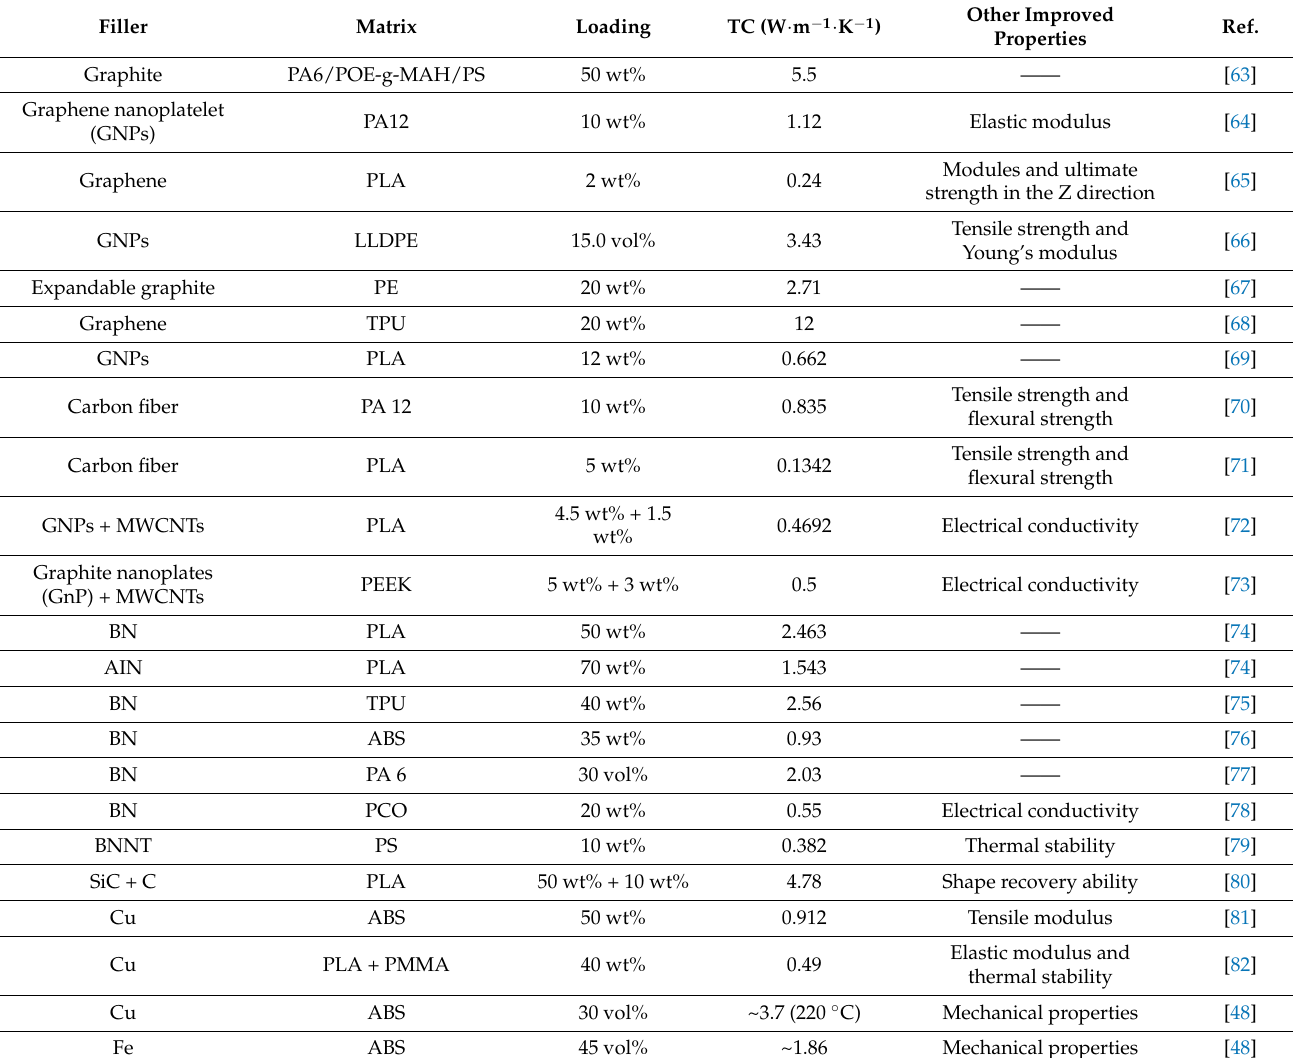
Table 2. Summary of FFF thermally conductive